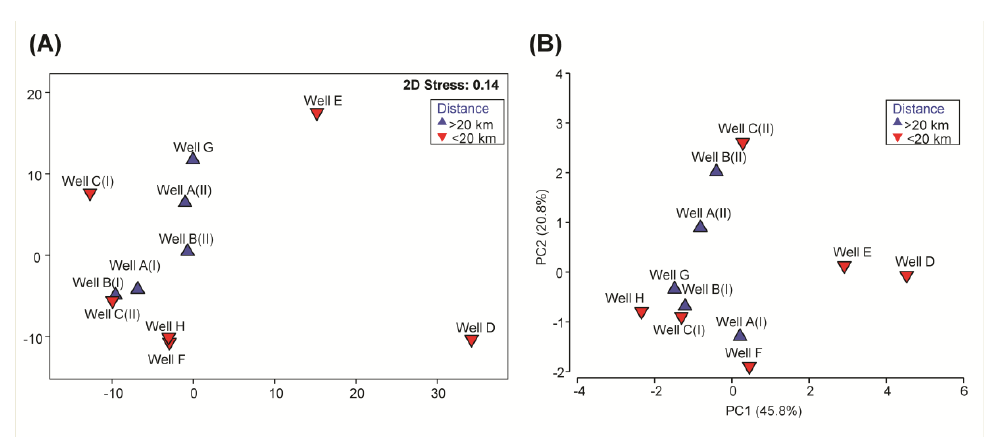
Figure 2. Clustering ordination analyses of groundwater wells A through H. ( A ) threshold metric dimensional scaling plot of groundwater microbial communities, ( B ) principal component analysis of water quality data. Data collated include the abundance of human-associated Bacteroides , 16S rRNA gene copy number, total cells, coliform density, total nitrogen and total organic carbon